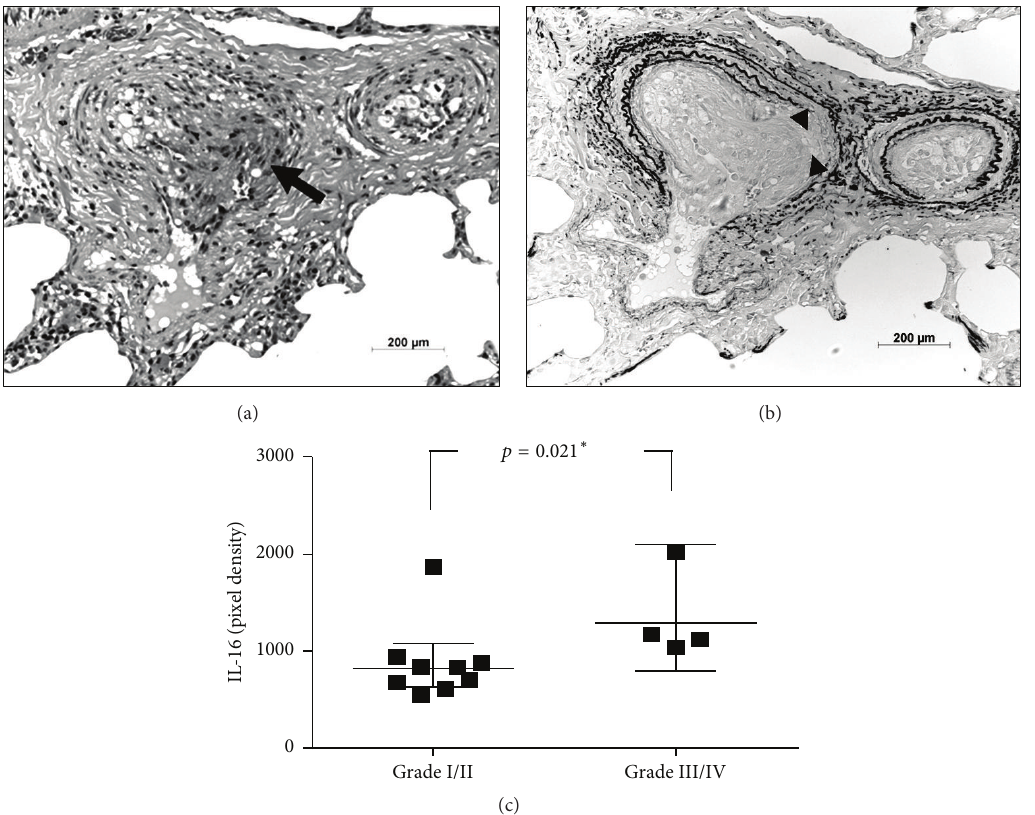
Figure3:Lungbiopsyfindingsandseruminterleukin16(IL-16).(a)Advancedpulmonaryvasculopathy(gradeIV)inayounggroupIIpatient (11 months old). Preacinar arteries are shown, with focal intraluminal proliferation of endothelial cells (arrow) characterizing the early stage of a plexiform lesion. (b) Histological section of the same arteries, stained for elastic fibers. At the site where the endothelial proliferation hematoxylin-eosin and Miller’s elastic stain; objective magnification 20x. (c) Serum levels of IL-16 (geometric mean with 95% CI) in